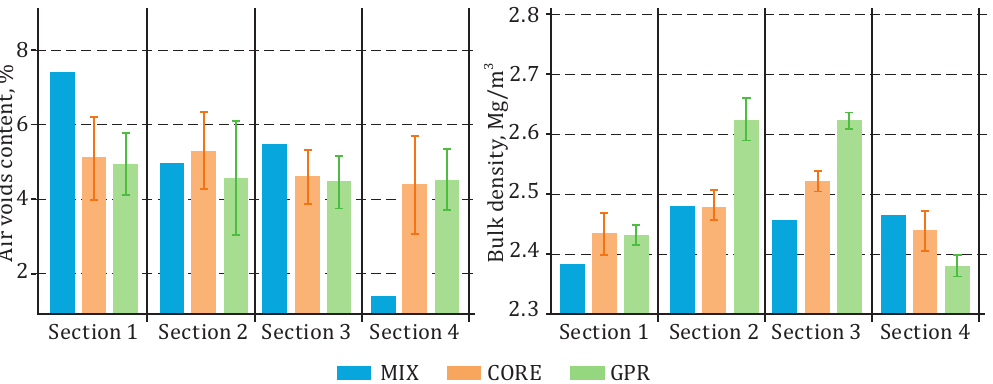
Figure 3. Comparison of the results and